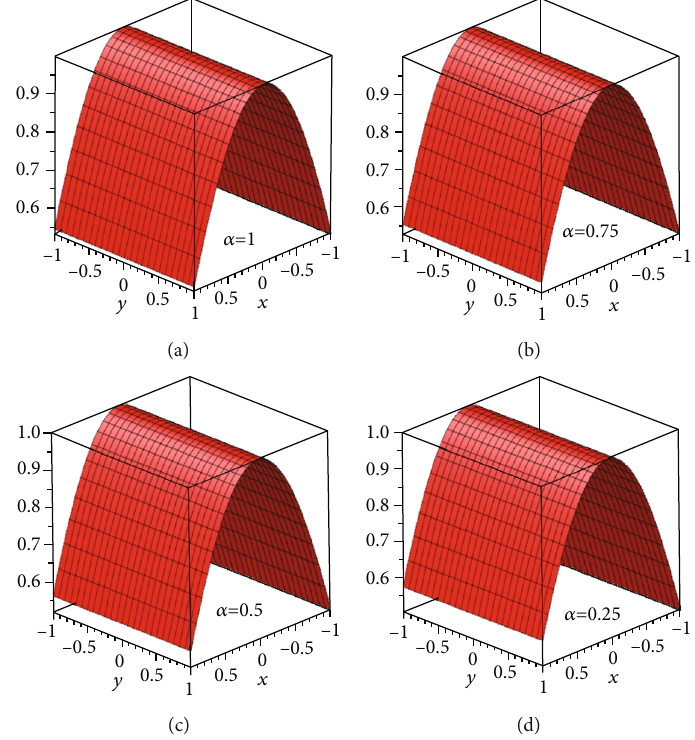
Figure 3: Nature of the proposed method solutions at di ff erent fractional orders for problem